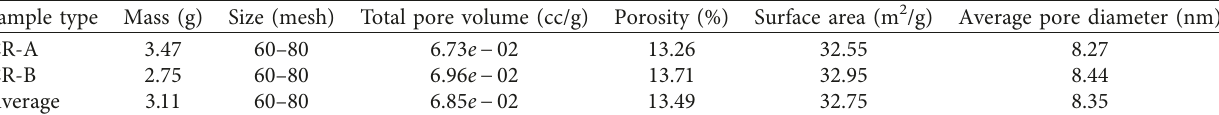
Table 4: NAD results.